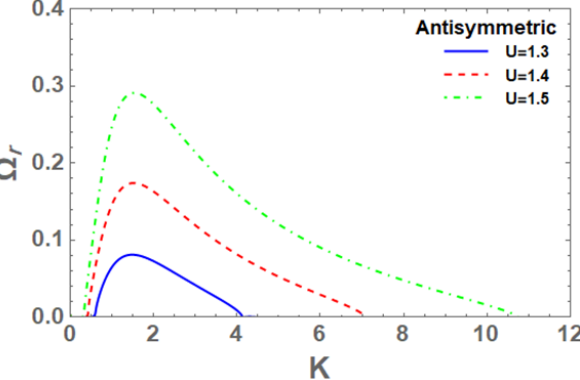
Figure 11. Variation of non-dimensional growth rate Ω r with non-dimensional wave number K for varied gas to liquid velocities U > 1, when We = 1000; Oh = 0.1; N = 1; ρ = 0.01; v = 0.2;